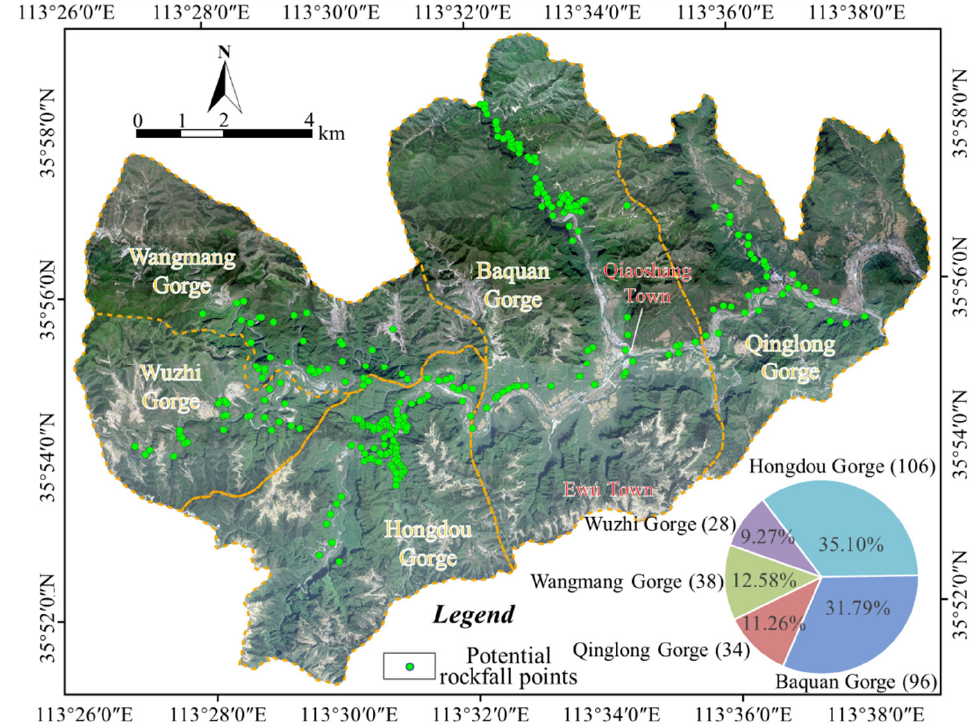
Figure 3. Distribution map of potential rockfall points in the Taihang GCSA.